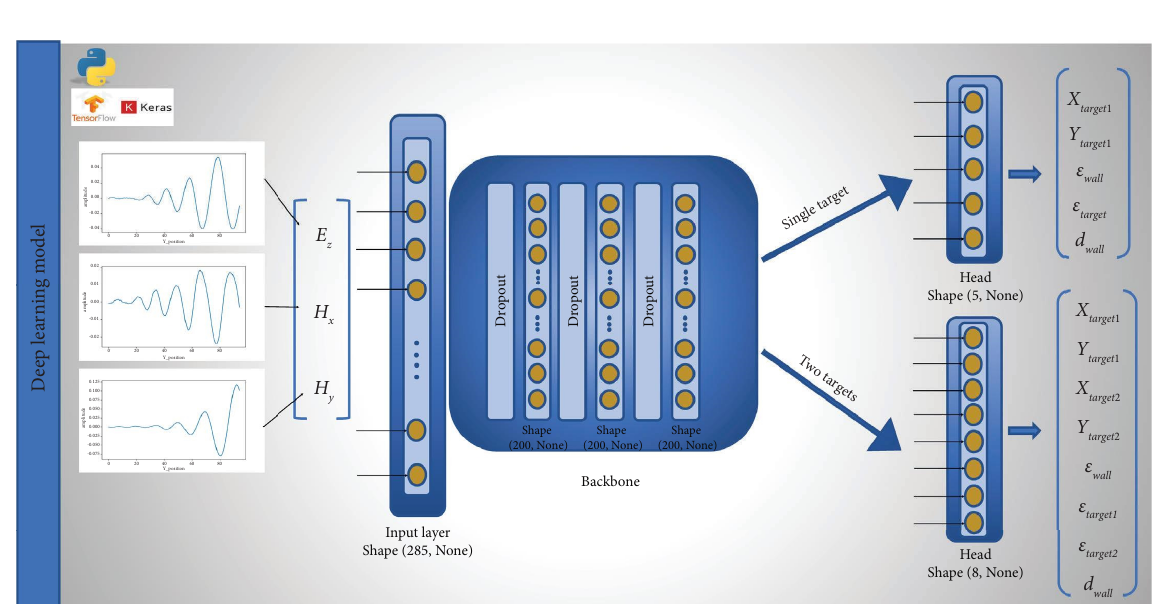
, H , H z x y felds and estimate the output